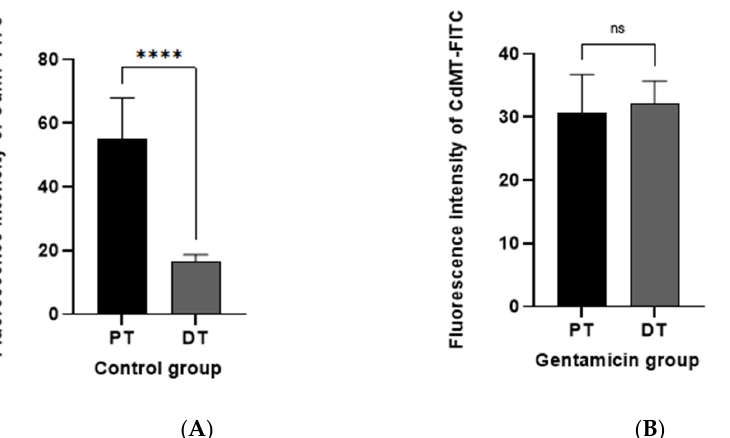
Figure 12. CdMT accumulates in the PT in control mice, which is compensated by the DT after PT damage induced by 10mg/kg gentamicin. Bar chart showing means ± SD of five randomized photo- graphs per animal (three animals per group) Quantification of CdMT complex immunofluorescence intensity (green) was performed on kidney sections. Student’s t -test was performed, ( A ) Control; **** p < 0.0001; ( B ) GM; p = 0.6769. ns = not significant.